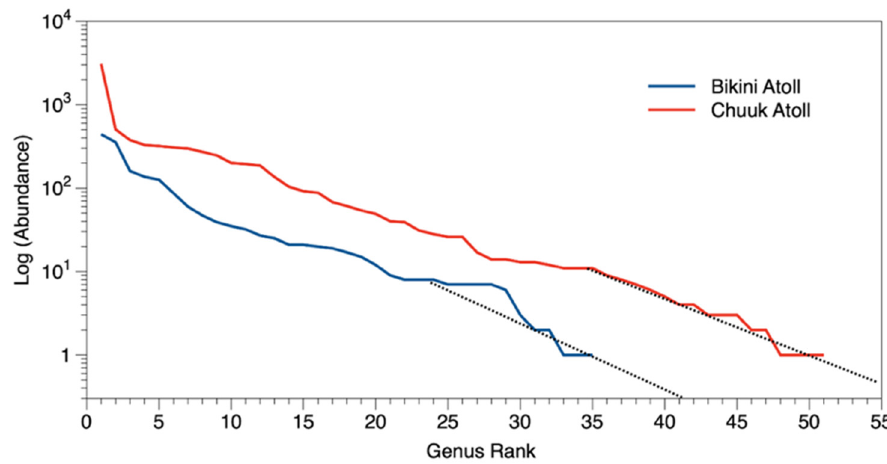
Figure 2. A rank-abundance diagram showing the estimated genus diversity of shipwrecks in Bikini (blue line) and Chuuk (red line) lagoons. Dashed lines are linear extrapolations for use in estimating true genus-level richness on each group of vessels.